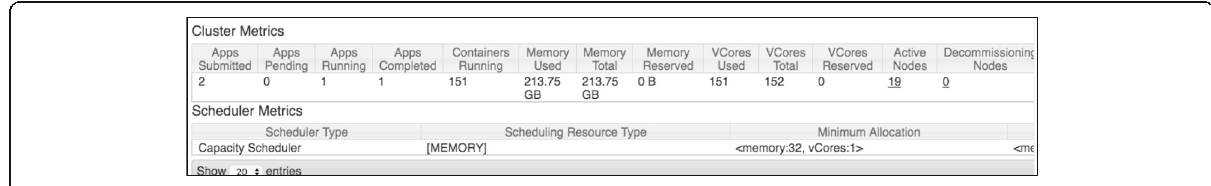
Fig. 5 19-node cluster resource utilization